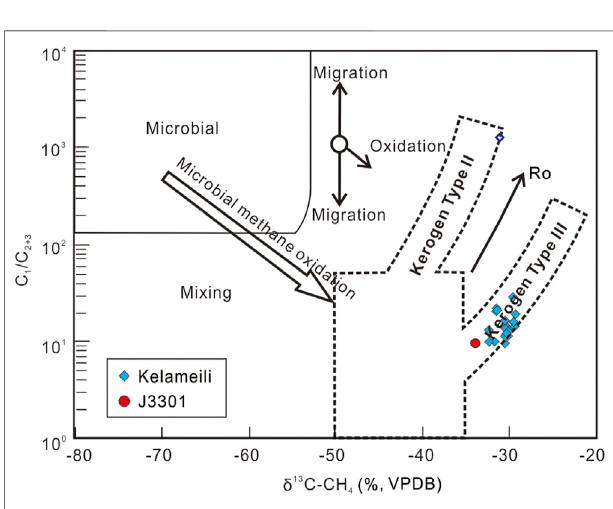
FIGURE 9 | Using the C 1 /C 2+3 vs δ 13 C-CH 4 plot to identify the genetic types of natural gases in the Jimsar Sag (Plot after Bernard et al., 1978; Whiticar,